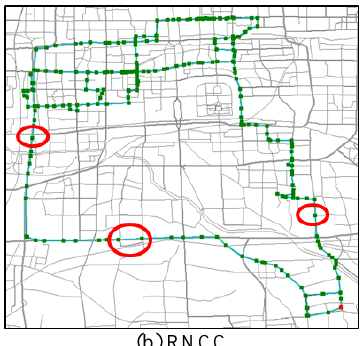
Figure 5. Part compressed results